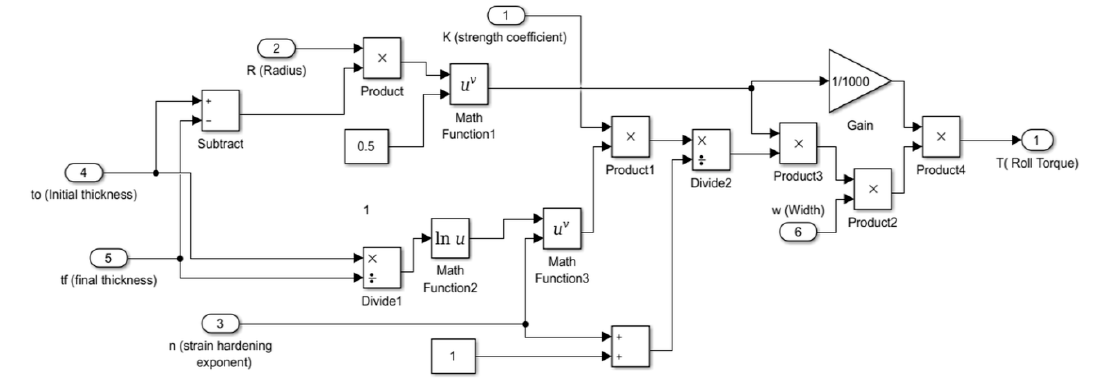
Figure 7. MATLAB/Simulink model of BLDC motor-drive system coupled with rolling process.